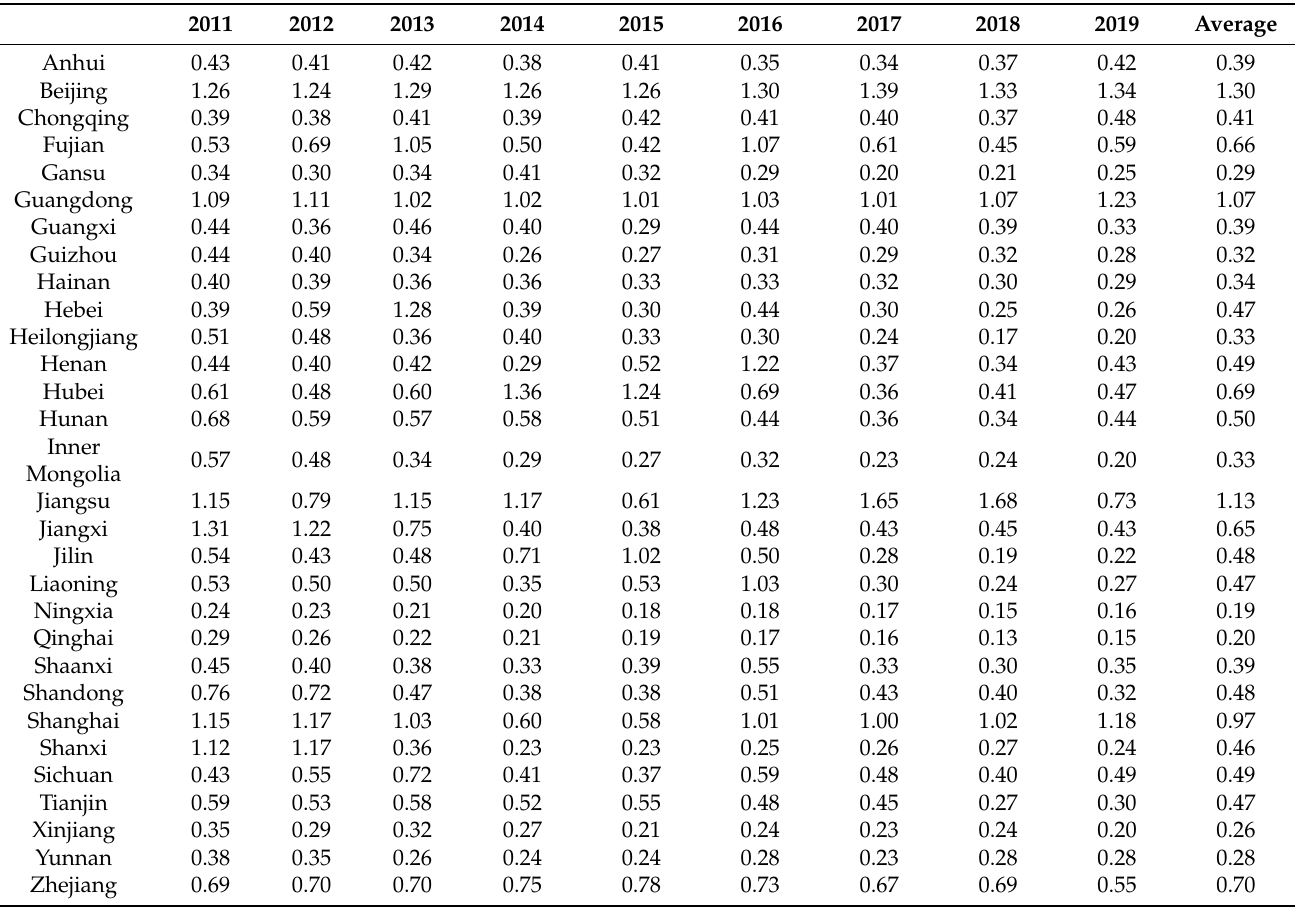
Table 4. Technical efficiency of 30